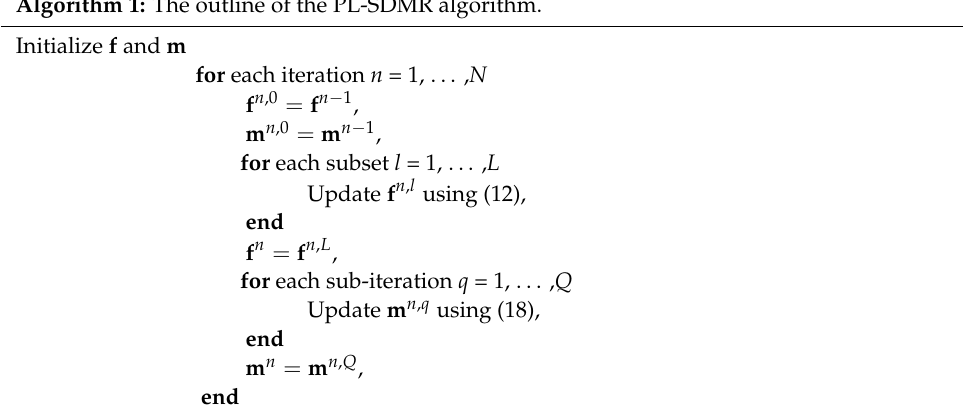
Algorithm 1: The outline of the PL-SDMR